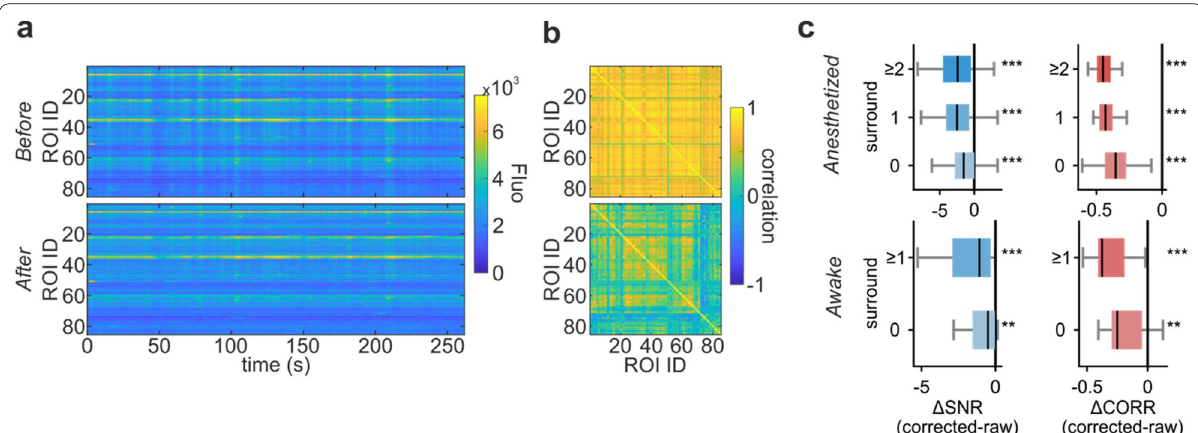
Fig. 4 Background activity subtraction. a Top. Fluorescence activity of the ROIs segmented in an example SLS acquisition. Each row in the raster corresponds to the activity of a ROI. Bottom. Fluorescence activity of the same ROIs after the subtraction of the background activity. b Pairwise correlations between ROIs in a before (top) and after (bottom) the subtraction of the background activity. c . Average SNR (blue, left) and pairwise correlations (red, right) difference between background-subtracted and raw data for anesthetized (top) and awake animals (bottom). Extended values in Table 3